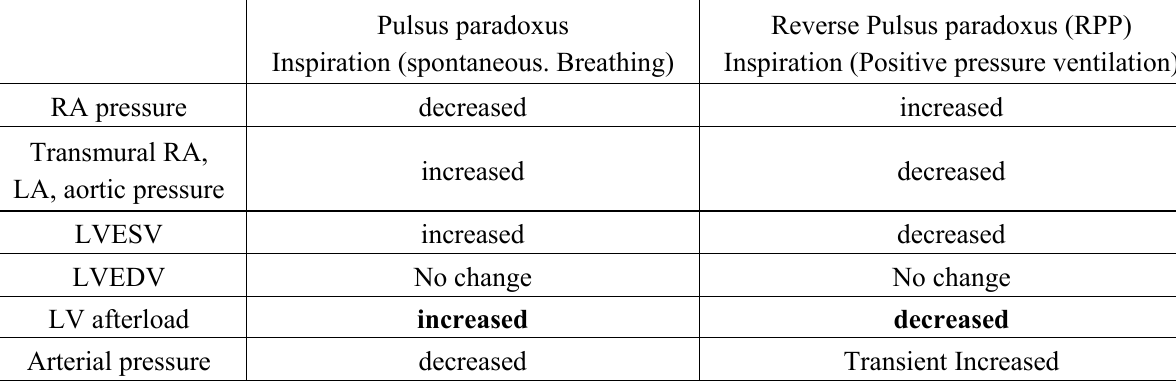
Table 2. Comparison between pulsus paradoxus and reversed pulsus